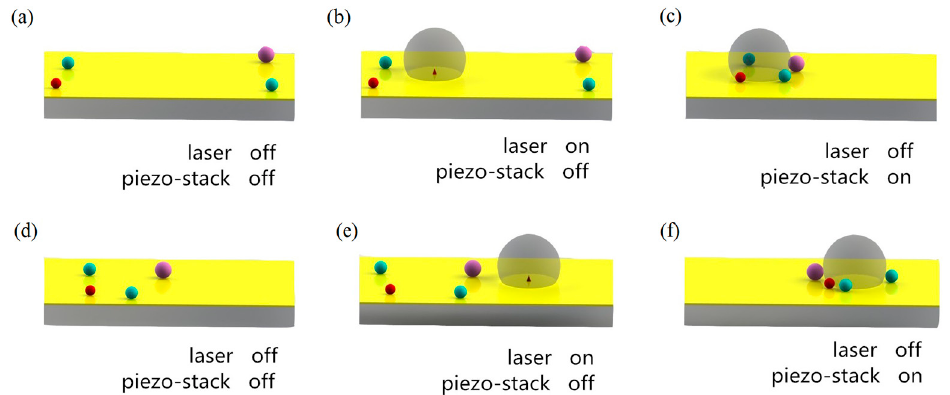
Figure 1. Collecting and transporting of micro-objects by oscillating vibrating bubbles: ( a ) micro-objects distributed on the chip; ( b ) a bubble generates on the chip; ( c ) piezoelectric stack is turned on and the particles are collected by the oscillated bubble; ( d ) the bubble bursts and the micro-objects disperse; ( e ) another bubble appears on the chip; ( f ) the new bubble collects these objects again.